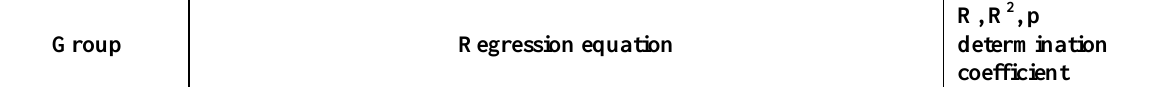
Competitive Performance-Anthropometric and Motoric Test Data Regressive Model for Children Aged 9-10 Group Regression